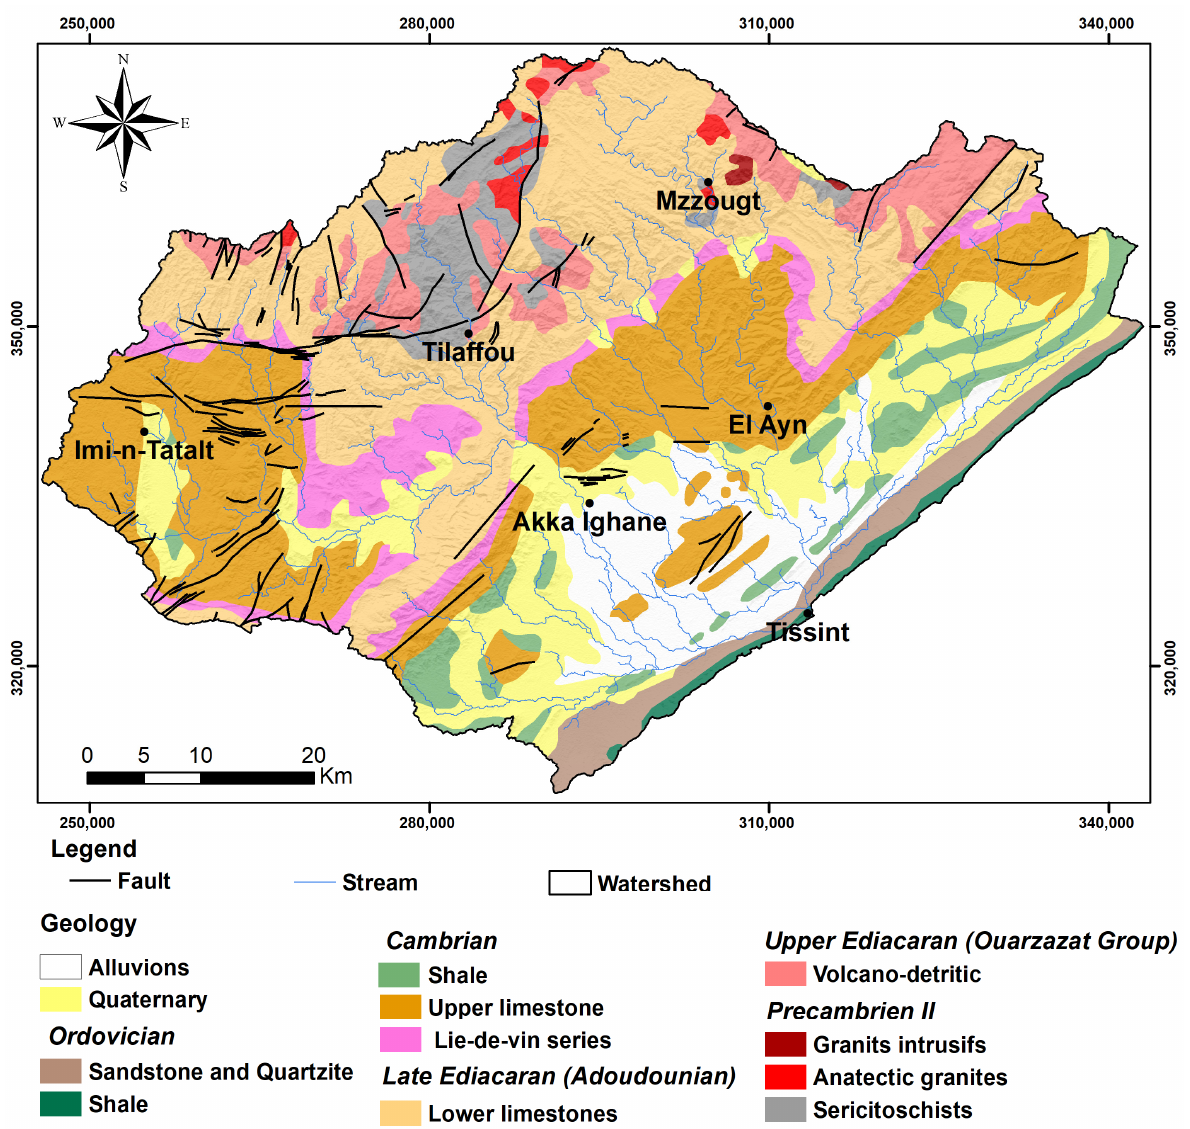
Figure 2. Geological map of Tissent